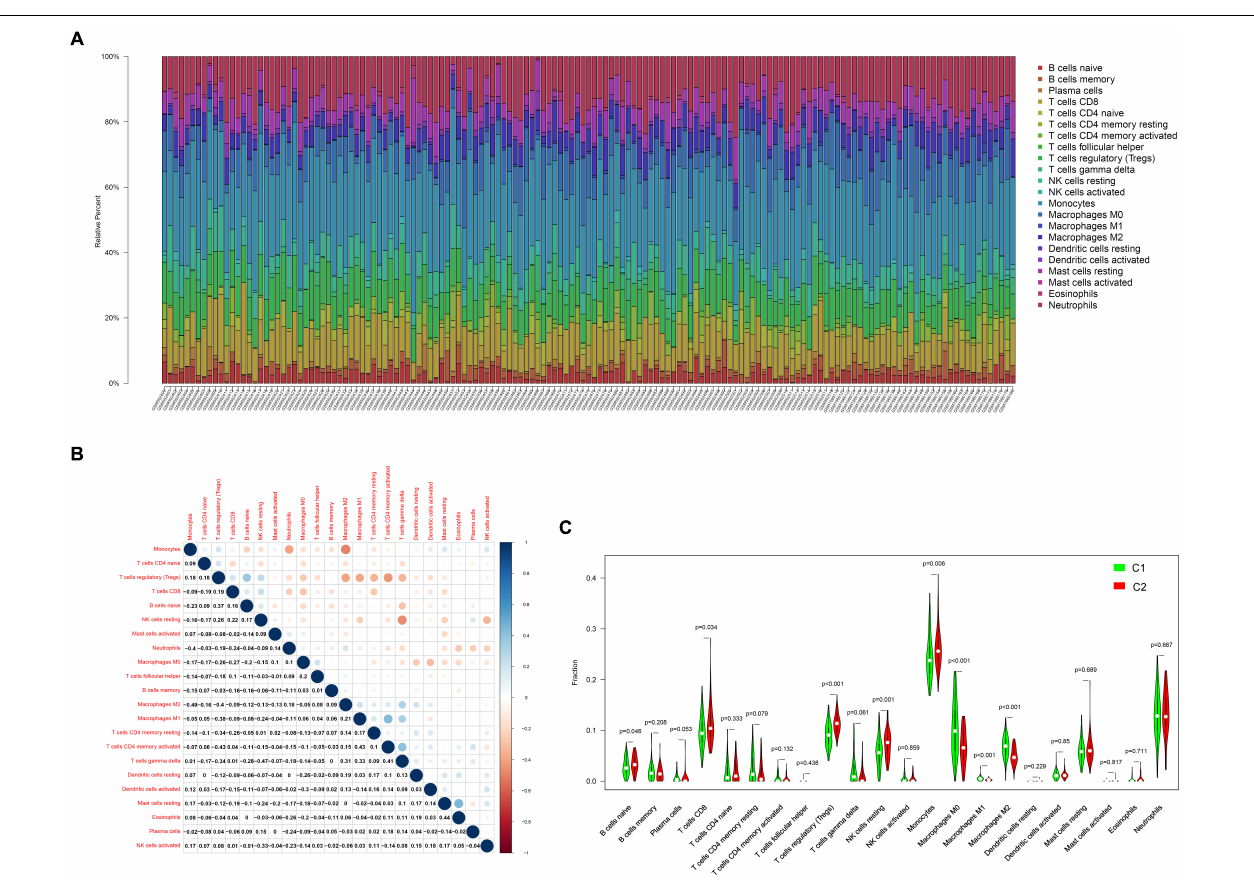
FIGURE 10 | The landscape of the level of infiltration of AS by 22 immune cells. (A) Barplot of the 22 immune cells infiltration level. (B) Correlation analysis of the 22 immune cells. (C) The comparisons of the 22 immune cells infiltration level between subtype C1 and C2.